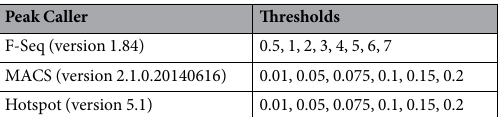
Table 1. Thresholds used for each peak caller in the analyses throughout the manuscript. For MACS and Hotspot, thresholds correspond to false discovery rate (FDR) and in case of F-Seq to z-score thresholds. Z-score thresholds are negatively correlated with FDR. Thus, small values correspond to high FDR thresholds and large values to low FDR